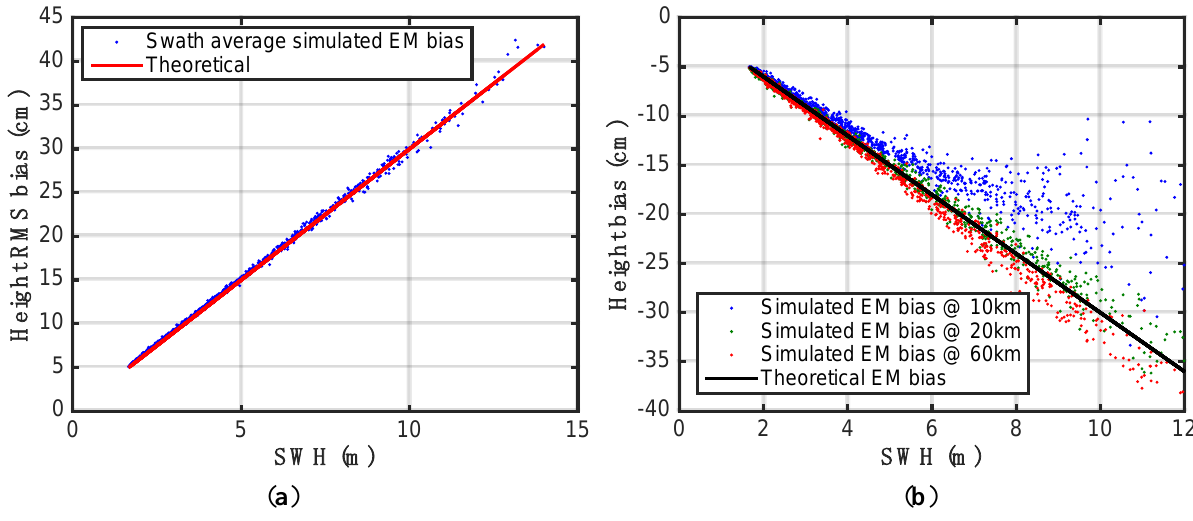
Figure 7. ( a ) Swath average electromagnetic bias as a function of SWH (blue), compared with the first order theory (red). ( b ) Electromagnetic bias at 10 km (blue), 20 km (green) and 60 km (red) as a function of SWH, compared with Equation (9) in black. Note the positive slope in (a) is due to the fact that the RMS value is